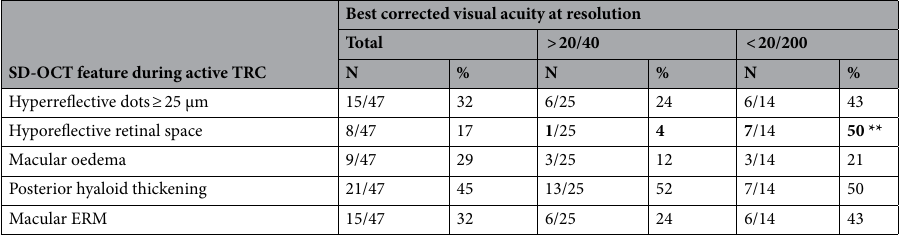
Table 4. Features on SD-OCT at any time during clinical course and visual outcomes in active TRC for 47 eyes of 47 patients, who were followed for at least 8 weeks and did not have a recurrence. Comparisons were made between eyes with good visual acuity (20/40 or better) and eyes with poor visual acuity (20/200 or worse). The p-values were calculated using Fisher’s exact test (** p < 0.01). SD-OCT = spectral domain optical coherence tomography; TRC = toxoplasmic retinochoroiditis; ERM = epiretinal